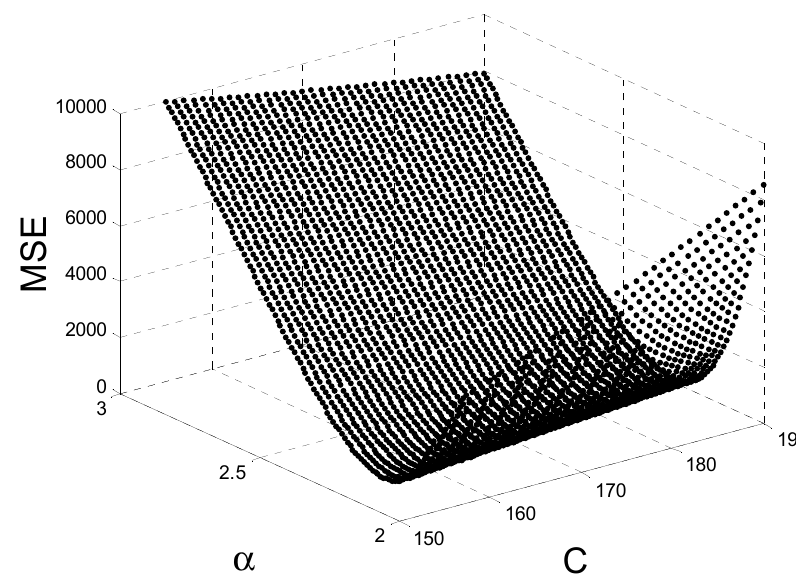
α and C parameter values in the